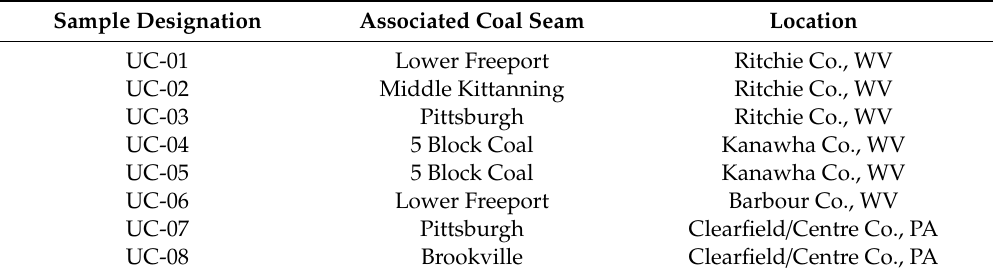
Table 1. Sample designations, associated coal seams, and